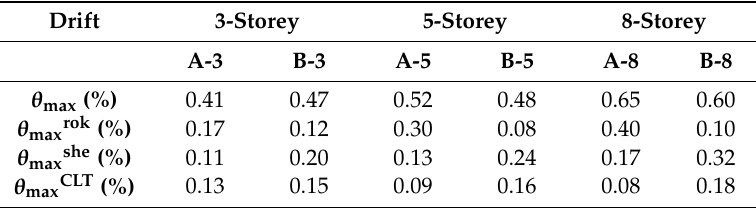
Table 7. Inter-storey drifts at DLS and their